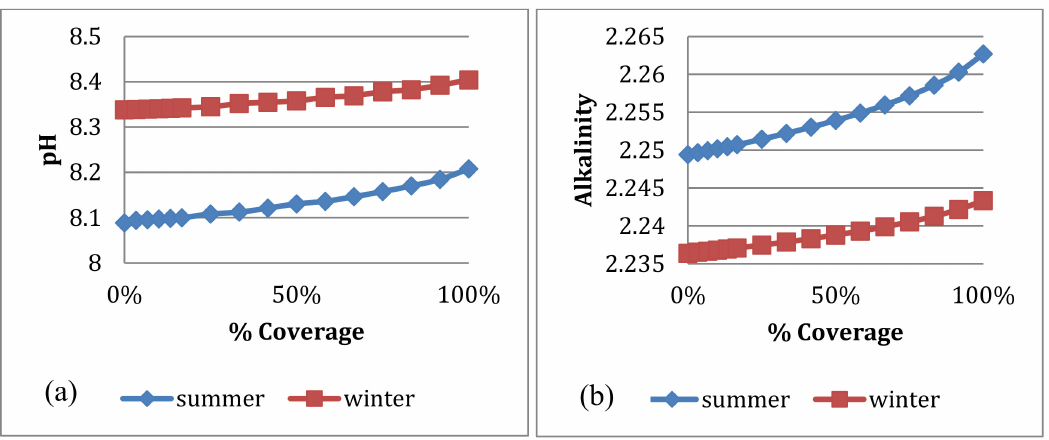
Figure 12. ( a ) pH values at the canal end in the summer and winter vs. percentage coverage for the 50-km length of the Canal, ( b ) the alkalinity of water at the canal end in the summer and winter vs. percentage coverage for the 50-km length of the